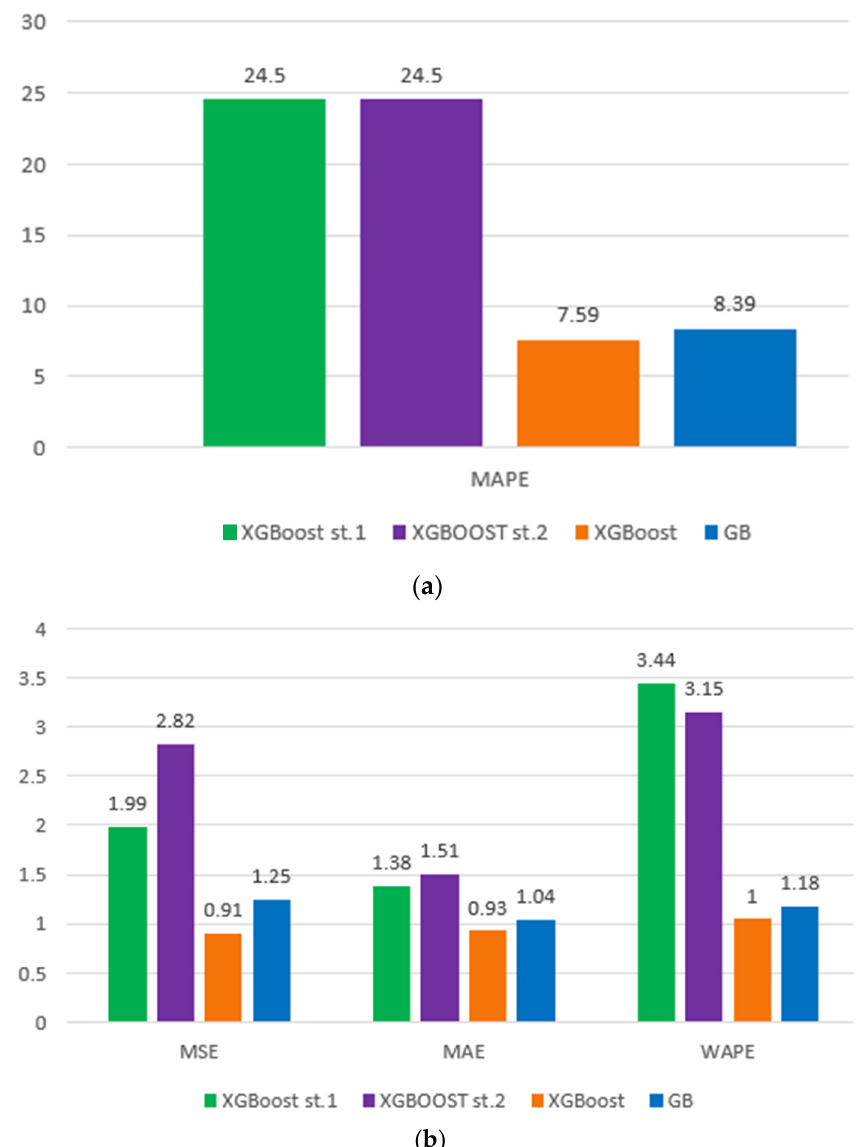
Figure 5. Accuracy metrics referred to the second validation test: MAPE ( a ); MSE, MAE and WAPE ( b ).